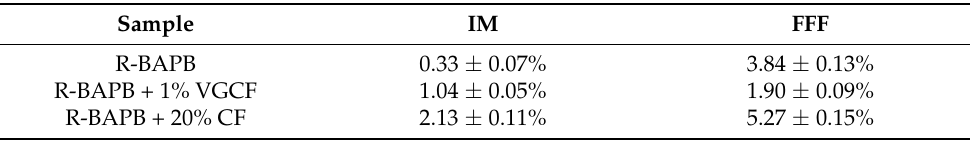
Figure 8. SEM images of the fracture surface of the studied samples (injection molding on the left; FFF printing on the right) from: ( a , b )—pure R-BAPB; ( c , d )—R-BAPB + 1% VGCF; ( e , f )—R-BAPB + 20% CF. Table 2. Comparison of porosity of the samples from R-BAPB-based composites produced by injection molding (IM) and FFF printing.